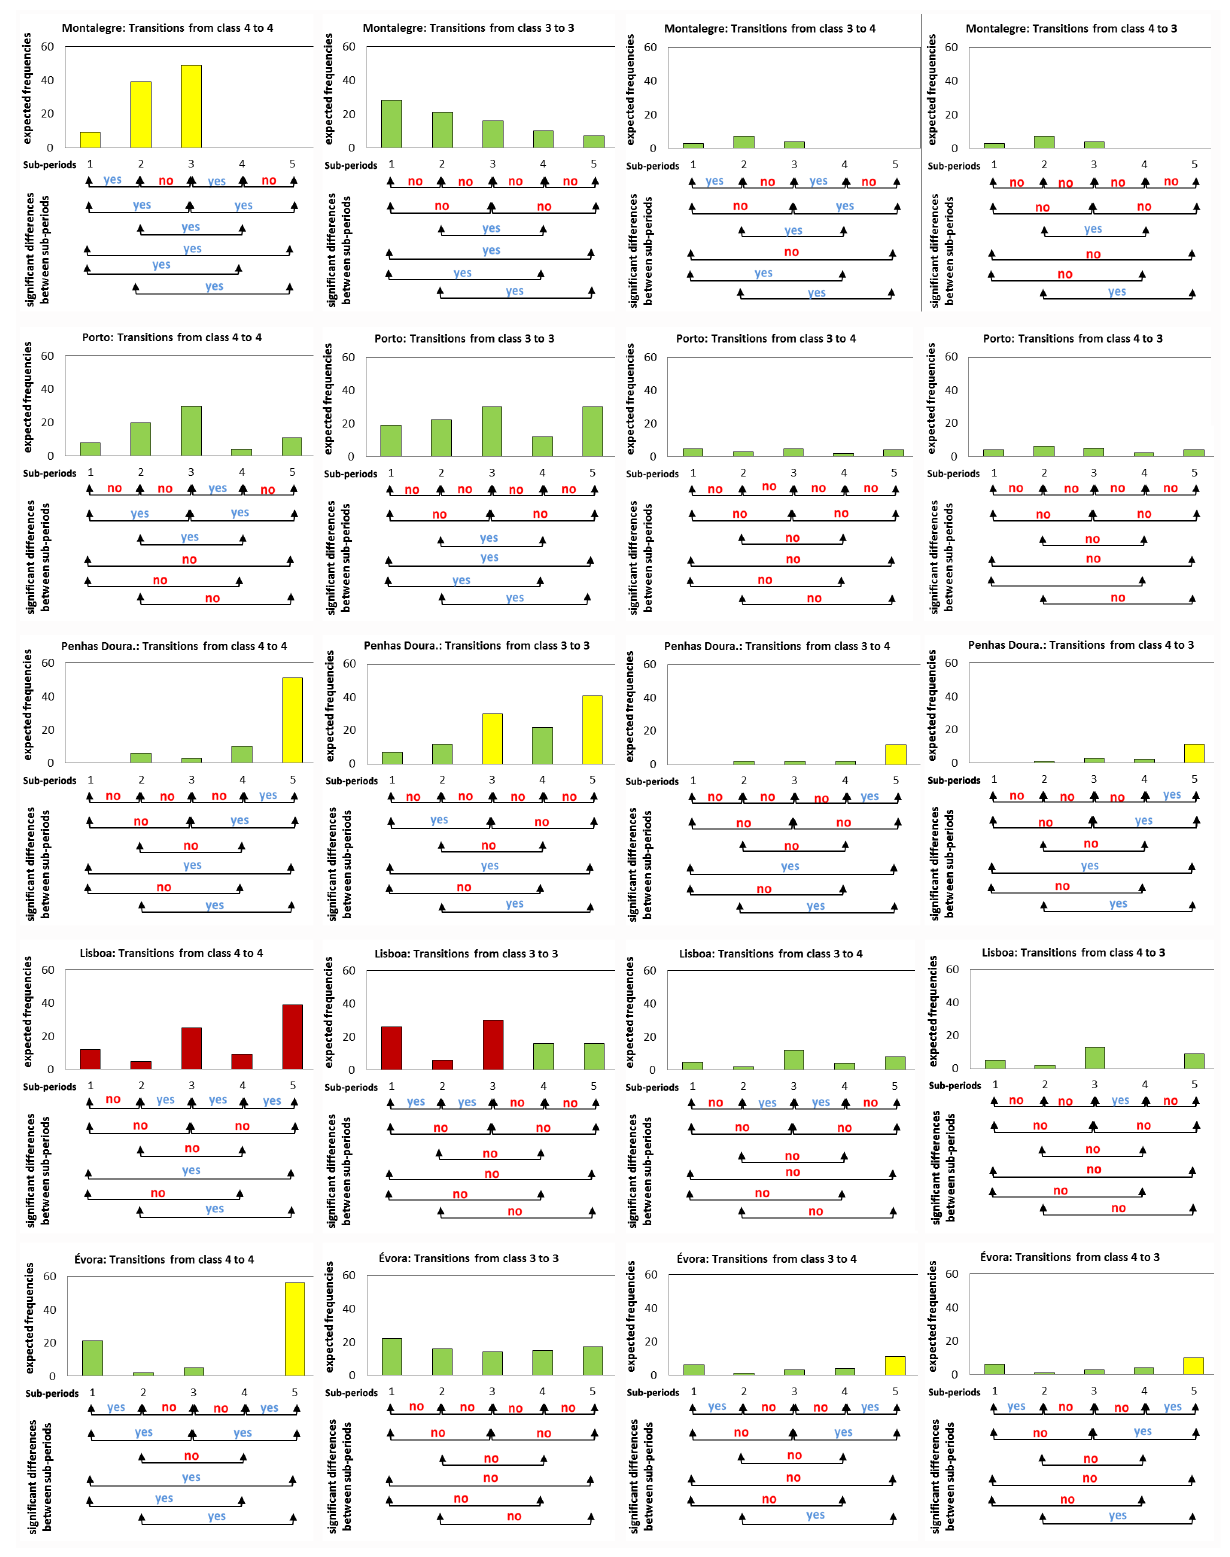
Fig. 5. Number of transitions between drought classes by sub-period and results for the Scheff´e multiple comparison of sub-periods. Arrows point to pairs of sub-periods being compared: “yes” when their differences are significant, “no” otherwise.